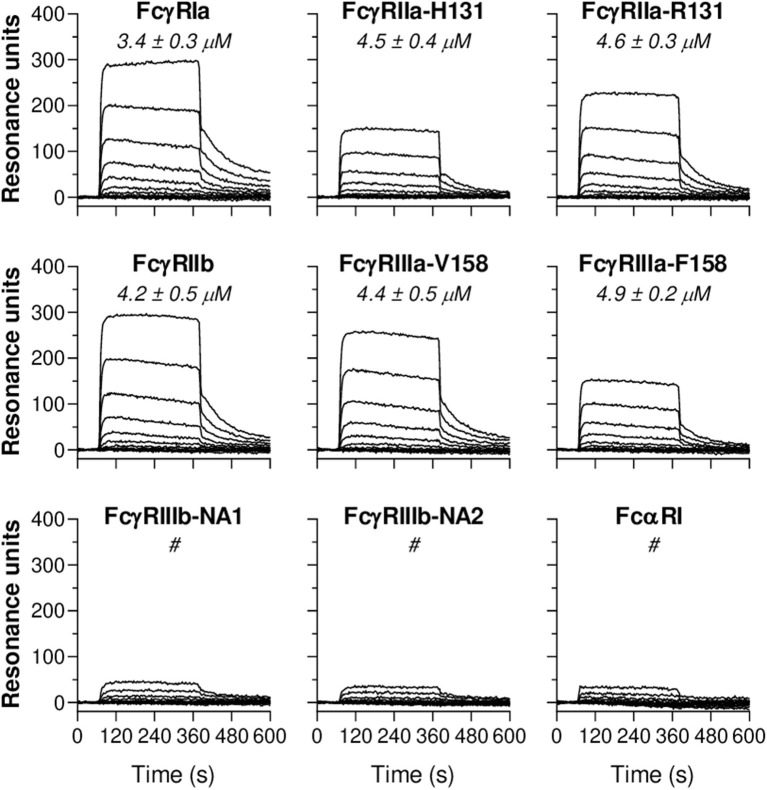
CRP binds immobilized human Fc receptors. Representative sensorgrams showing binding kinetics of human CRP to C-terminally immobilized human FcγR classes (FcγRIa, FcγRIIa-H/R131, FcγRIIb, FcγRIIIa-V/F158, FcγRIIIb-NA1/NA2) and FcαRI. Depicted data are representative for three independent experiments where CRP binding was imaged in real-time and simultaneously to FcRs spotted at different densities (100–1 nM). Each line represents the kinetics of a specific CRP dilution (1:1 serial dilutions ranging from 2,000 to 1 nM). For all receptors, in each sensorgram CRP's exact binding affinity is depicted by the mean KD value (μM ± S.E.M., averaged from triplo data) at Rmax of 500. # indicates binding of CRP to the receptor which was too low to calculate KD.